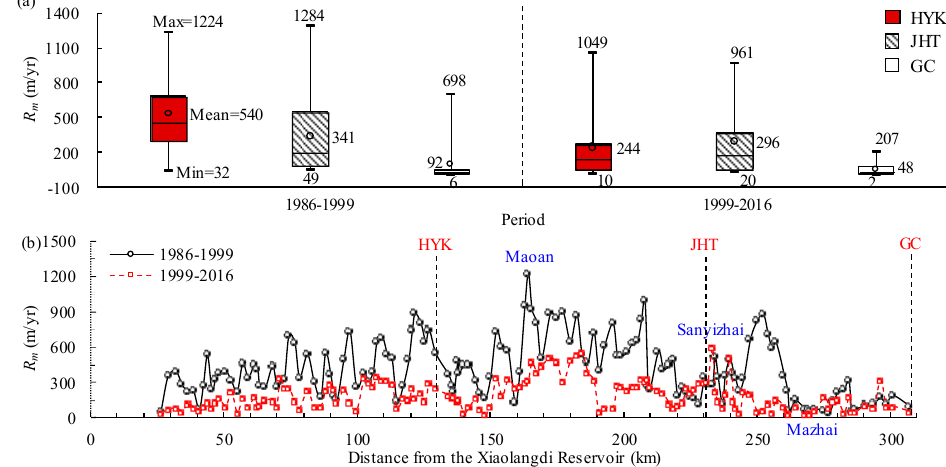
Figure 10. Temporal variations in the section-scale migration rate of channel centerline: ( a ) at sections of HYK, JHT and GC; ( b ) at all the sections in the braided reach. In general, the migration rates of channel centerline varied greatly along the braided reach, and were influenced by various factors such as the conditions of water discharge and sediment concentration, and channel boundary conditions [3]. During the period 1986–1999, the largest migration rate of channel centerline occurred at the Maoan section situated 66.2 km upstream of JHT, with the value of 1225 m/yr. After the Xiaolangdi Reservoir operation, the maximum migration rate (exceeding 590 m/yr) in 1999–2016 occurred at the Sanyizhai section located 2.9 km downstream of JHT, while the minimum value was about 20 m/yr occurring at the Mazhai section located 37.6 km downstream of JHT. In addition, only 19 of the 145 cross-sections after the reservoir operation had a larger migration rate than the value before the reservoir operation, which indicates that the migration degree of channel centerline was reduced remarkably, with the channel braiding property weakening, caused by the water impoundment and sediment retention of the Xiaolangdi Reservoir. Figure 10b also reveals that the rate of channel migration was the most dramatic in the HYK–JHT sub-reach. One of the most important reasons can be explained as follows. The critical shear stress of the river bank soil is generally much lower than the near-bank shear stress of the flow because of its weak erosion-resistance and lower clay content, and the shear strength of bank soil can be determined by the internal friction angle and cohesion, with their values decreasing greatly with an increase in water content [52]. Therefore, the riverbanks in this sub-reach were prone to being scoured and collapsing, which made it possible for the channel centerline to shift from one branch to another. Figure 10 indicates that the characteristics of channel migration at a specified section or in a local sub-reach made it difficult to represent the migration trend of a whole study reach, and that the reach-scale migration rate needs to be investigated.